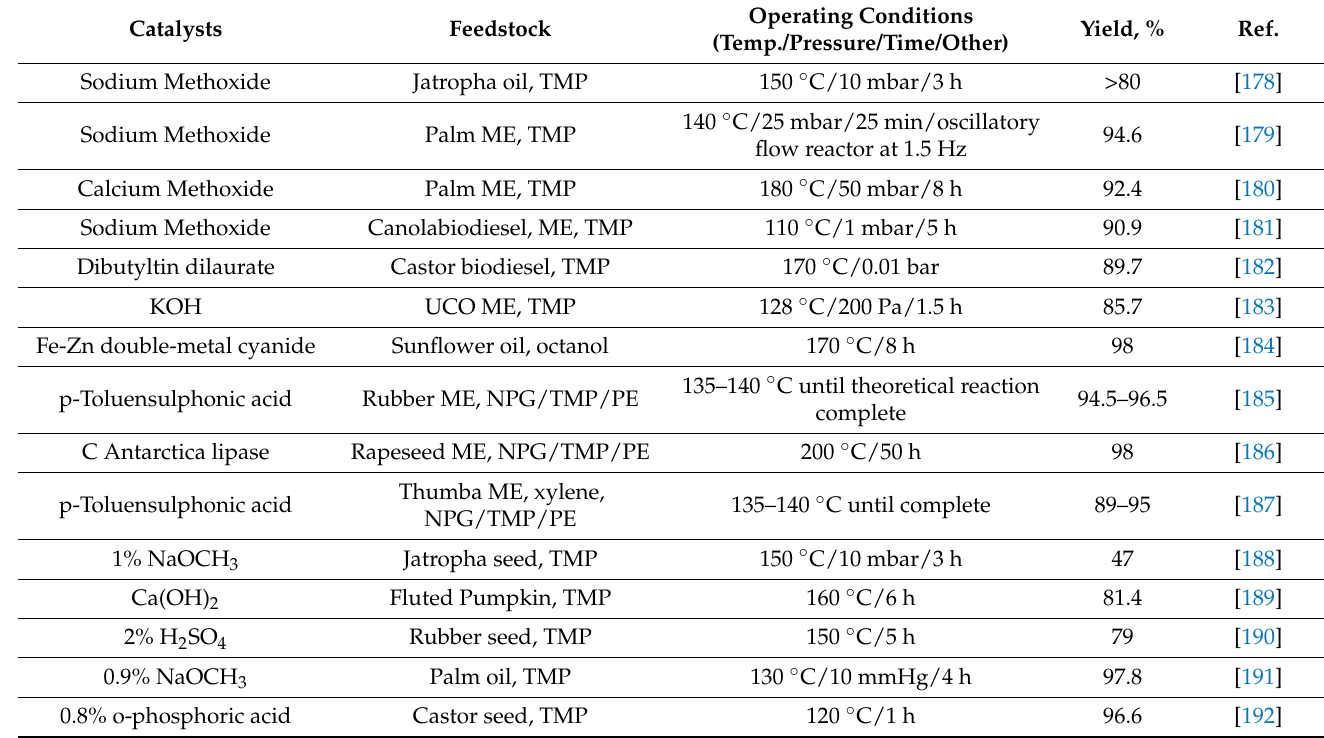
Table 8. The overview of catalysts used for biolubricant triesters.